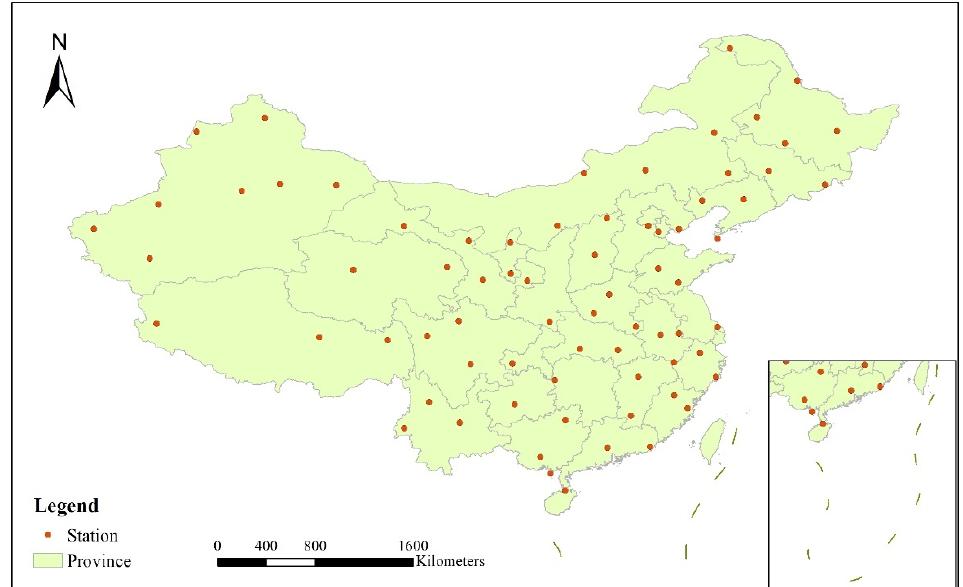
Figure 1. Distribution of solar radiation stations in China .